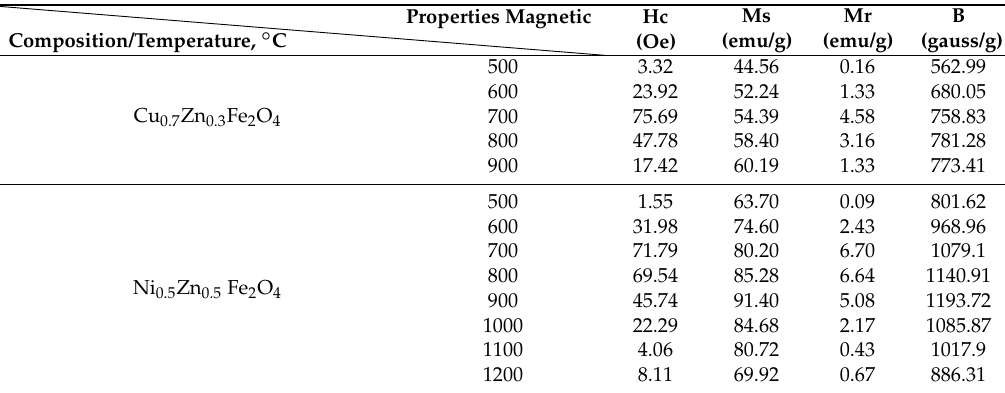
Table 2. The effect of sintering temperature on the magnetism of ferrite.